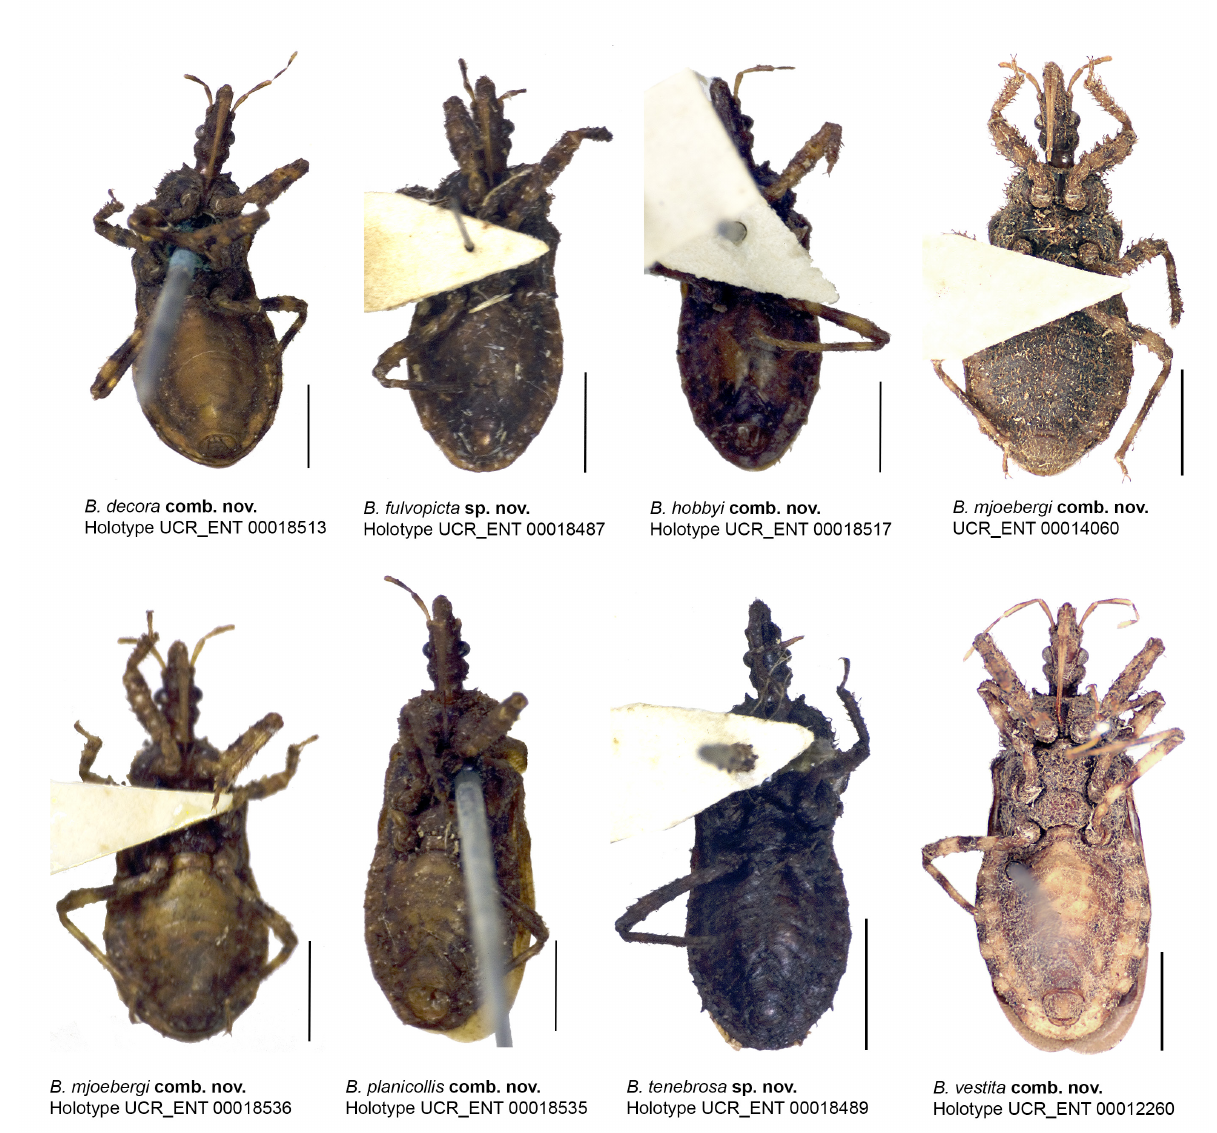
Fig. 5. Ventral habitus images for species of Breviphysoderes gen. nov. Scale bars = 2